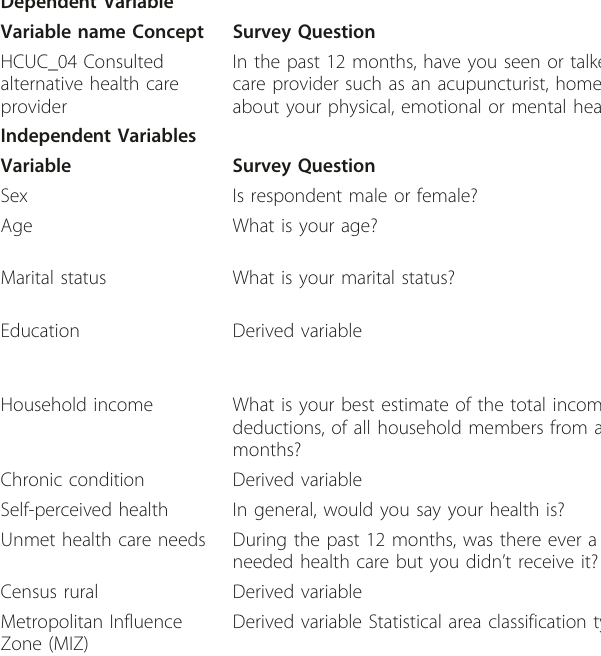
Table 1 Canadian Community Health Survey